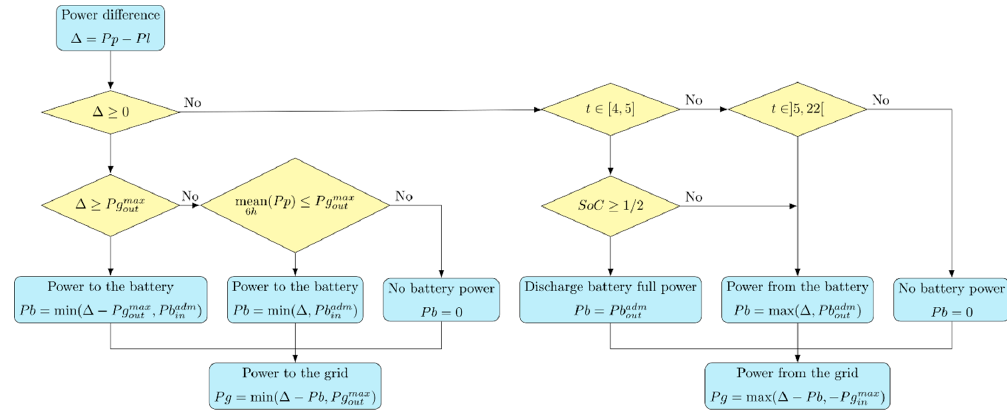
Figure 10. Flowchart of RBC3.